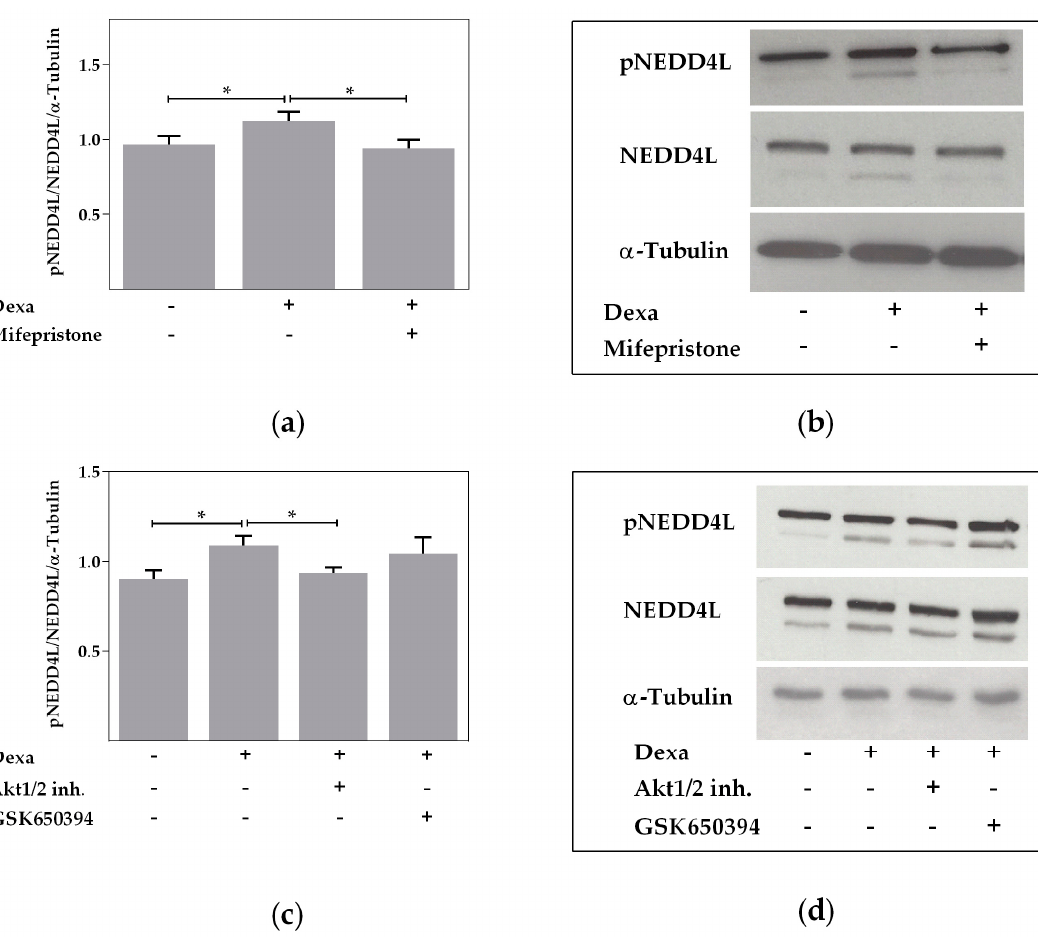
Figure 6. Dexa increases phosphorylation of neural precursor cell expressed, developmentally downregulated 4-like (NEDD4L). ( a ) Normalized densitometric evaluation of pNEDD4L, NEDD4L and α -tubulin Western blots. Calu-3 cells were treated with 100 nM dexa and mifepristone (10 µM) for 24 h ( n = 5; * p < 0.05 by t -test); ( b ) western blot of pNEDD4L and total NEDD4L resulted in bands of 110 and 135 kDa. Western blot of α -tubulin resulted in bands of 52 kDa; ( c ) normalized densitometric evaluation of pNEDD4L, NEDD4L and α -tubulin Western blots. Calu-3 cells were treated with 100 nM dexa and Akt1/2 kinase inhibitor (10 µM) or GSK650394 (10 µM) for 24 h ( n = 5; * p < 0.05 by t -test); ( d ) western blot of pNEDD4L and total NEDD4L resulted in bands of 110 and 135 kDa. Western blot of α -tubulin resulted in bands of 52